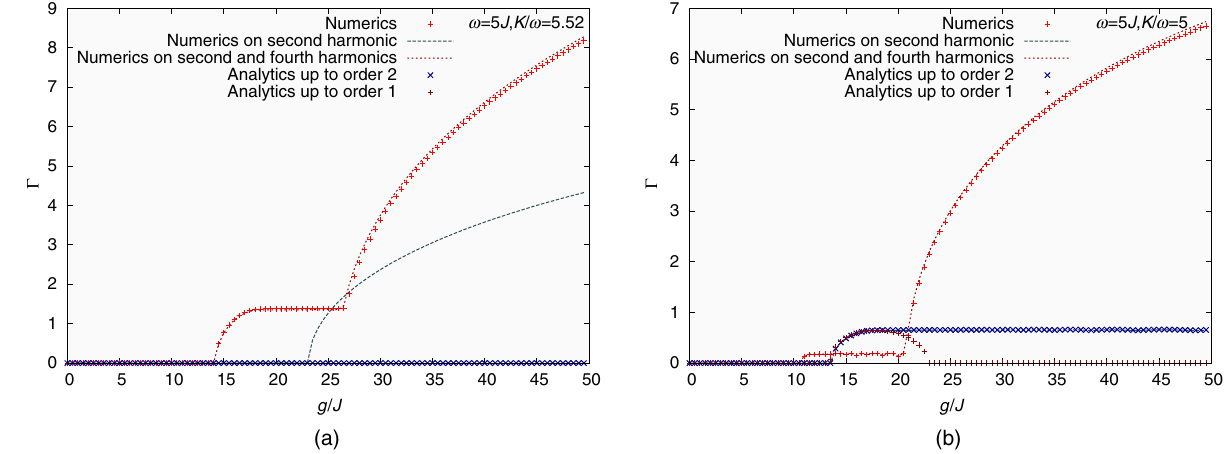
FIG. 21. Comparison between the numerically and analytically computed instability rate Γ in the cases K= ω ¼ 5 . 52 [(left panel), zone D of the stability diagram of Fig. 2, where J 0 ð K= ω Þ ≈ 0 ] and K= ω ¼ 5 [(right panel), zone E of the stability diagram of Fig. 2, where J ω Þ ≈ 0 ]. The disagreement in those cases can be due to a breakdown of the perturbative approach [when J 2 ð K= panel)] and/or a vanishing of the second harmonic [when J 2 ð K= ω Þ vanishes, (right